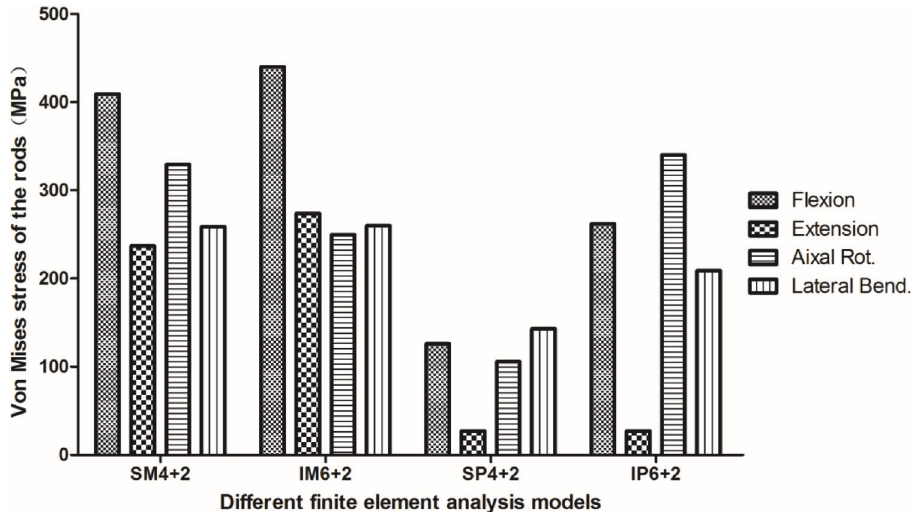
Figure 3 - von Mises stress of the rods. SM4 + 2/SP4 + 2 : short-segment monoaxial/polyaxial pedicle screw fixation; IM6 + 2/IP6 + 2 : intermediate monoaxial/polyaxial pedicle screw